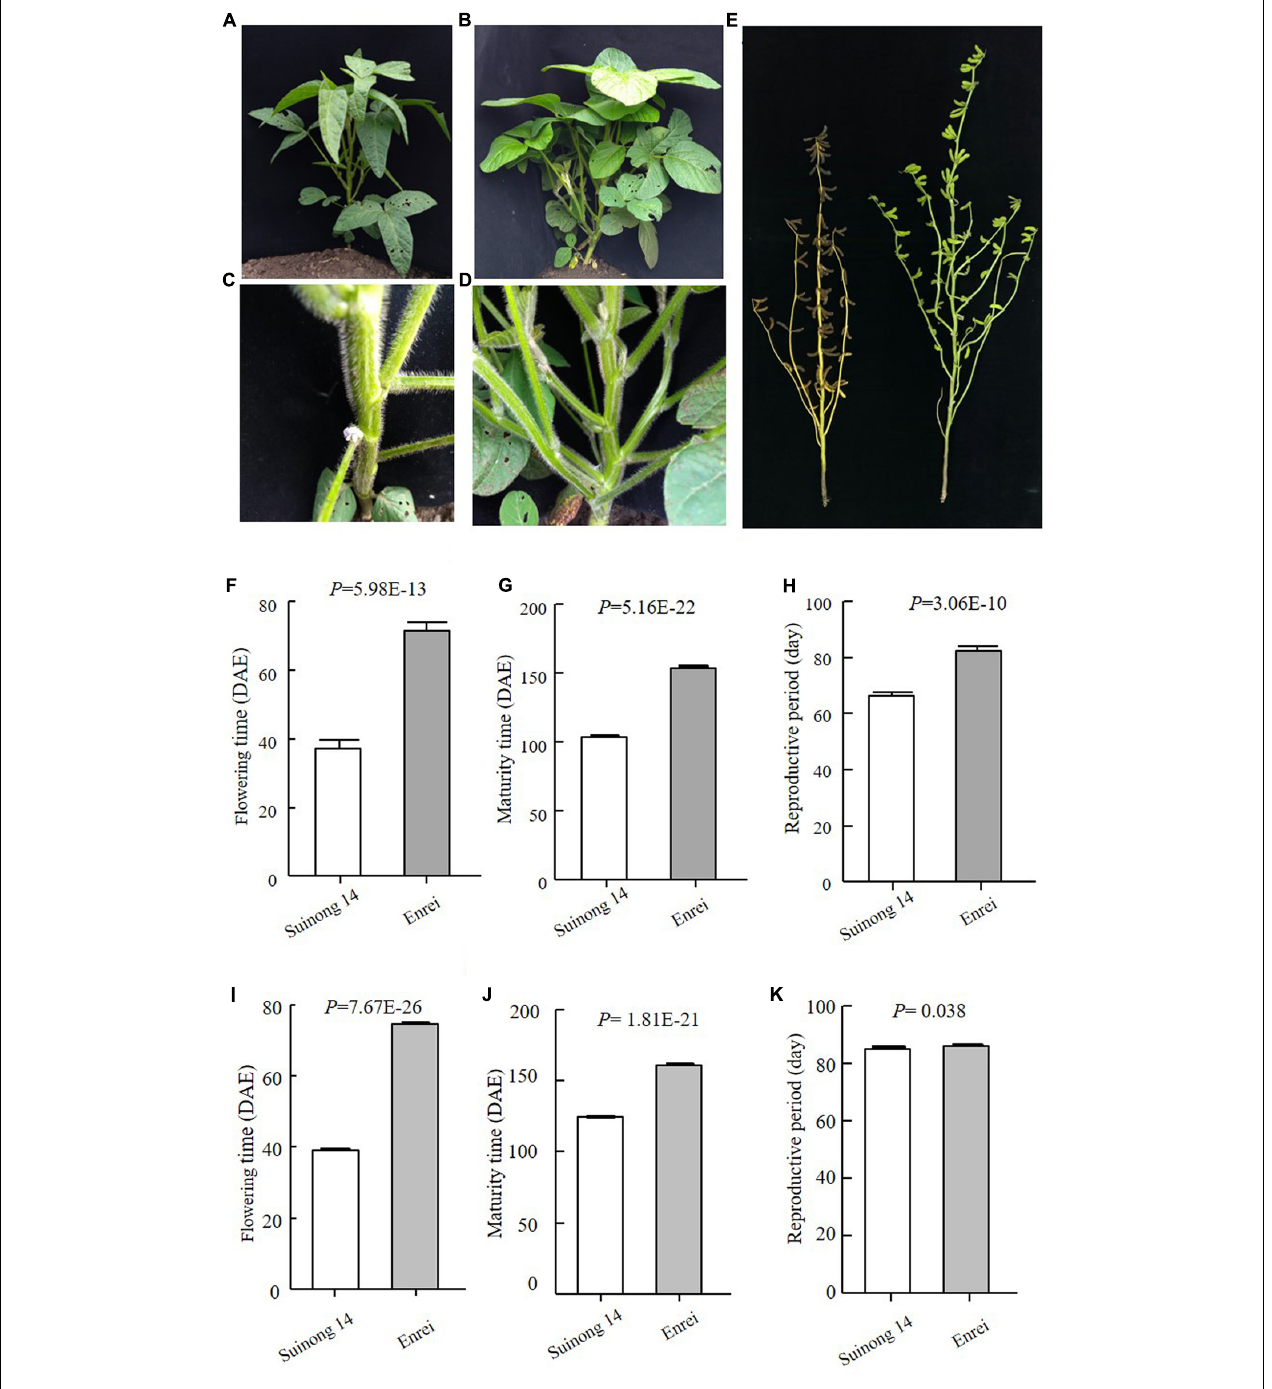
FIGURE 1 | Phenotypes of the parents of SE population. (A–D) Plants when Suinong 14 had flowered, while Enrei was still in the vegetative growth stage. ( A,C Suinong 14; B,D Enrei). (E) . Plants when Suinong 14 has already fully matured, while Enrei was still in the seed filling growth stage. Left is Suinong 14 and right is Enrei. (F–H) Phenotypes data of the parents in 2016, Harbin. (I–K) Phenotypes data of the parents in 2017, Harbin. DAE, day after